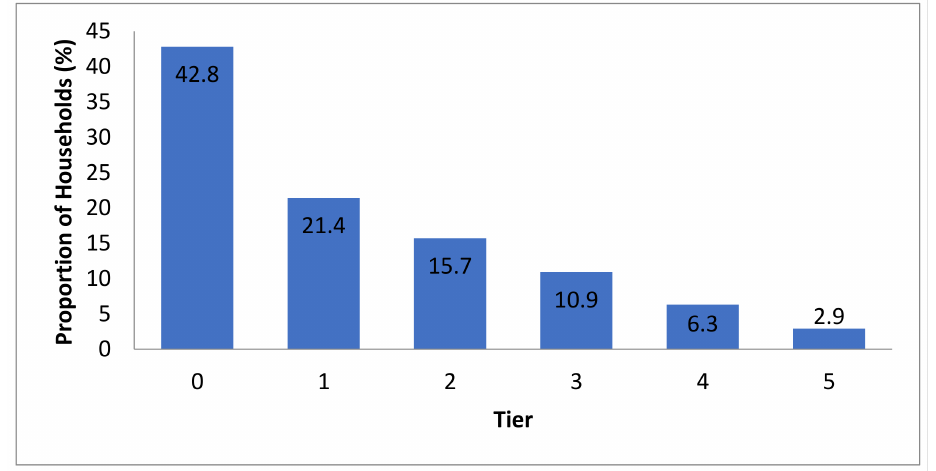
Figure 4. Overall electricity